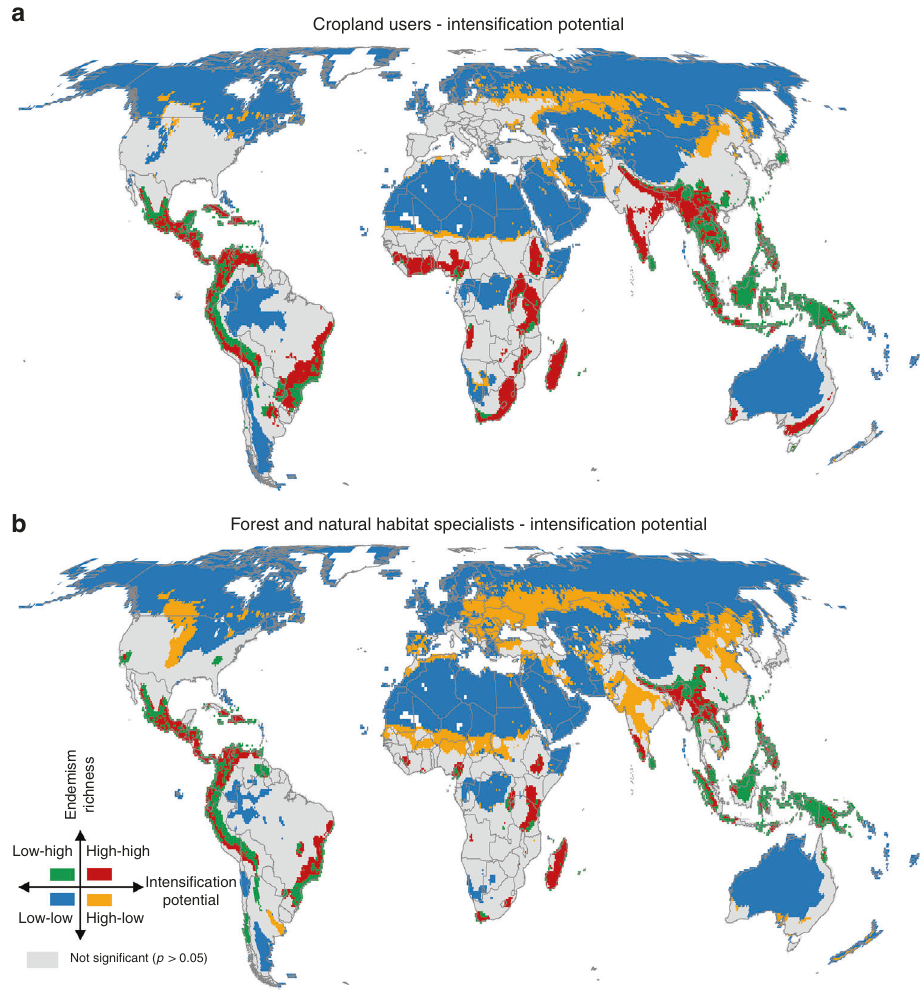
Fig. 4 Spatial association between potentials for cropland intensi fi cation and endemism richness for a regular or marginal cropland users and b forest or natural habitat specialists. They are calculated using local indicators of spatial association (LISA) at 55-km resolution. High – high clusters indicate hotspot locations (red), in which areas most suitable for intensi fi cation of cropland are signi fi cantly associated with high values of cropland users/forest or natural habitat specialists (at 0.05 signi fi cance level). Low – low clusters (blue) show cold spot locations, in which areas with low potential for intensi fi cation are associated with low values of cropland users/forest or natural habitat specialists. High – low and low – high clusters show inverse spatial